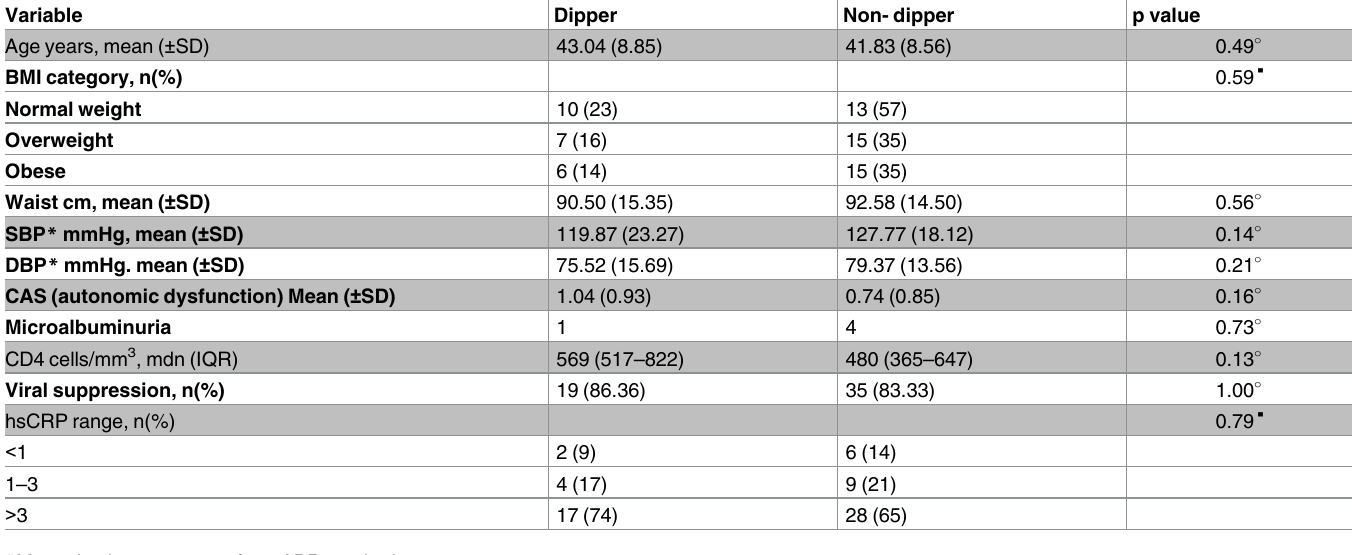
Table 2. Comparison of cardiovascularrisk factors between BP dippers (n = 23) and non-dippers (n = 43).